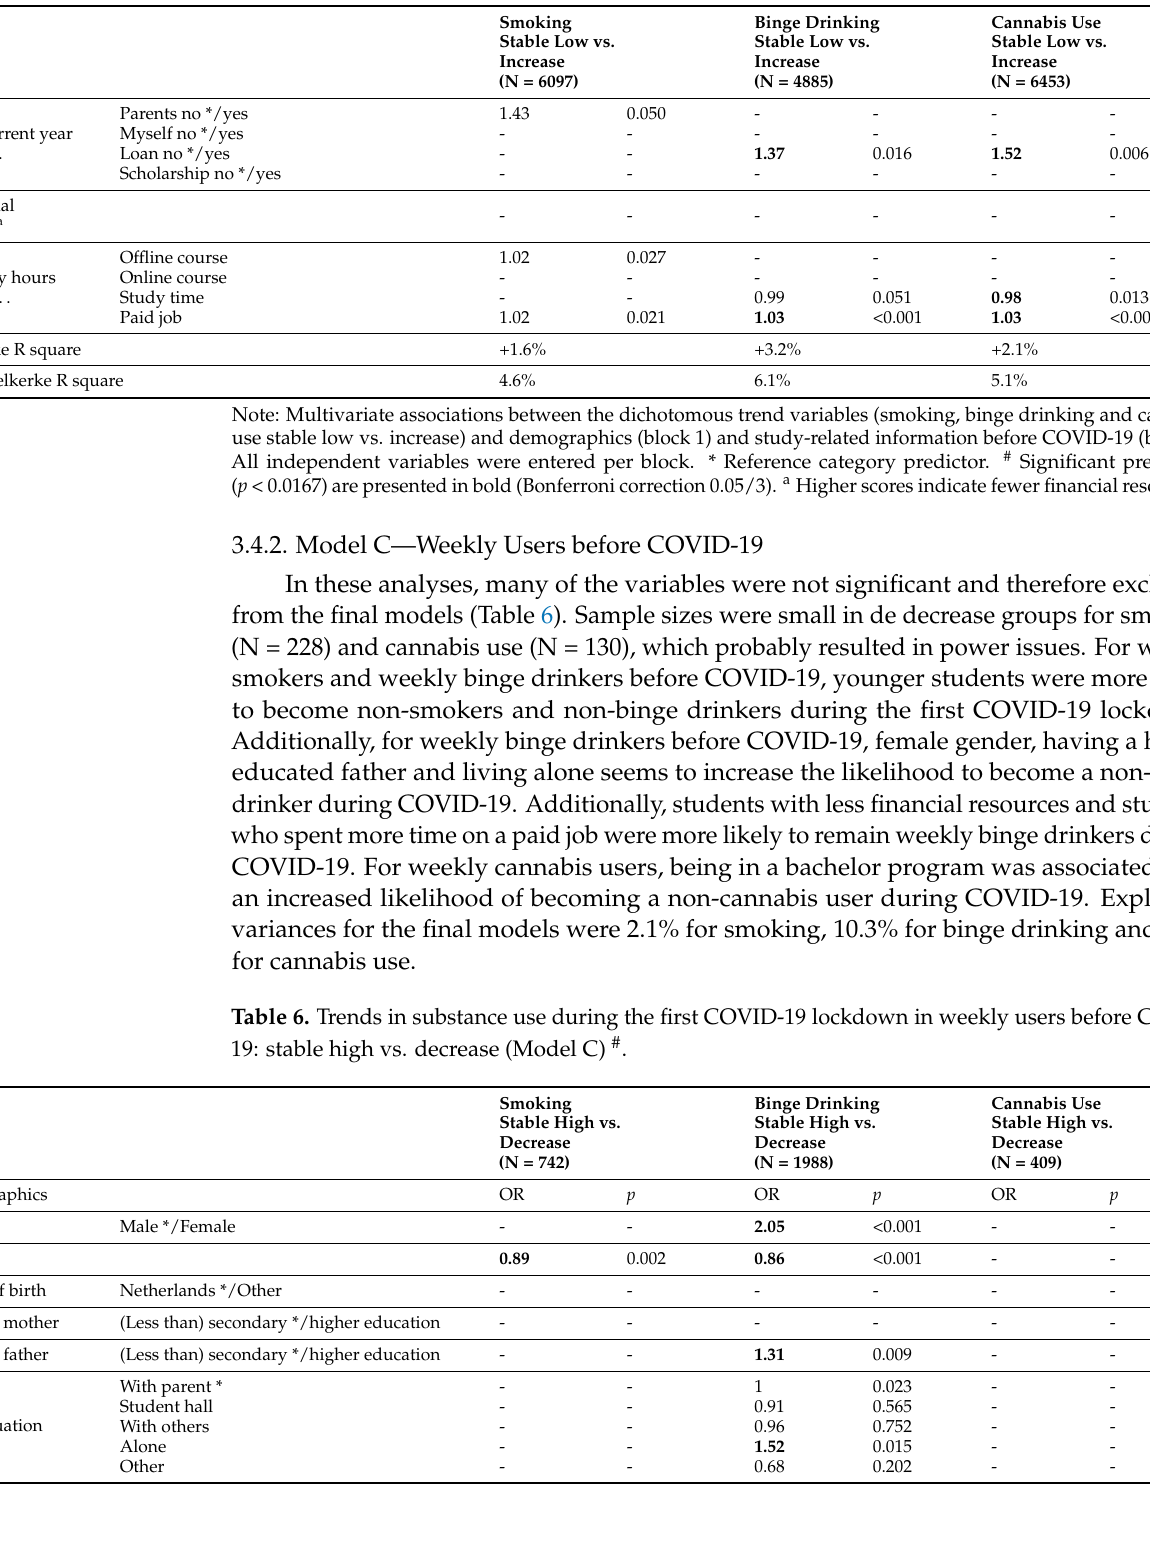
Smoking Stable Low vs. Increase